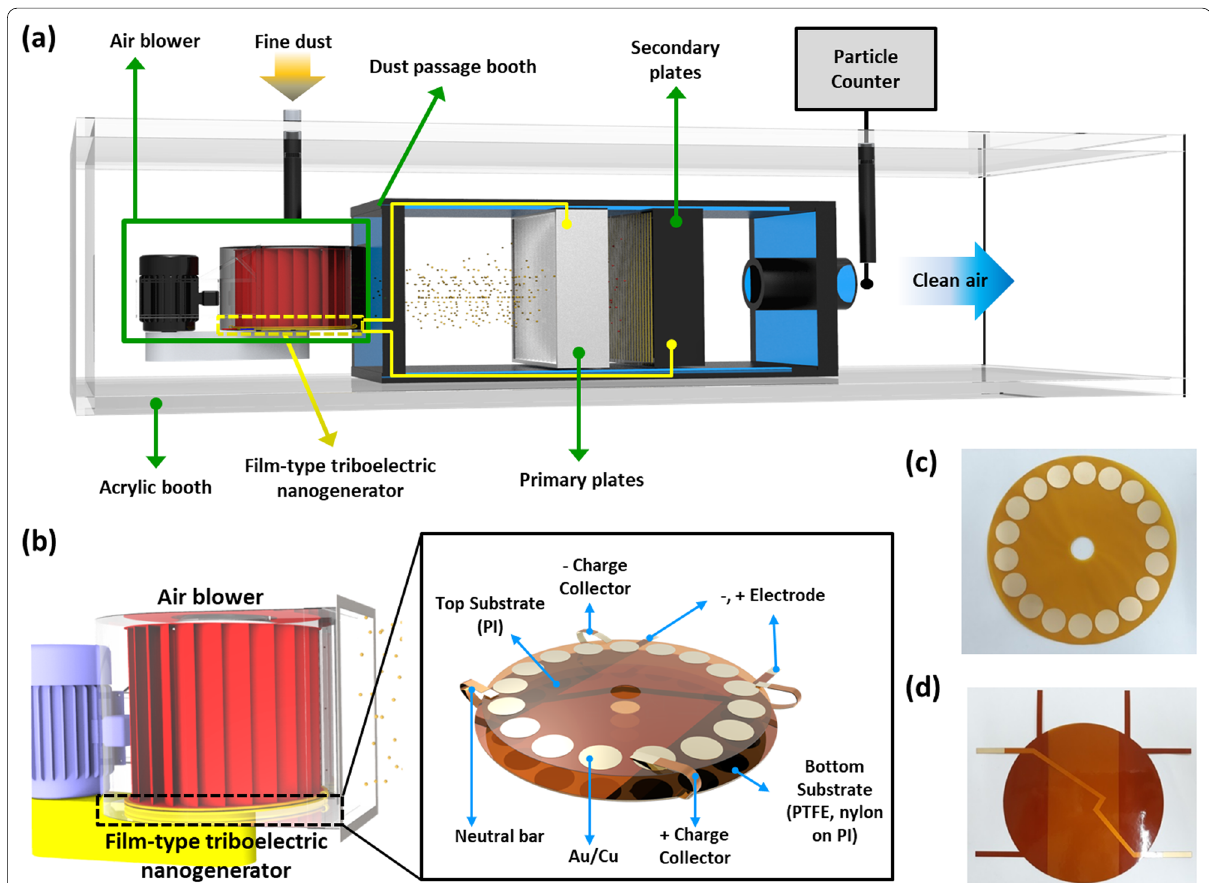
Fig. 1 a Schematic description of the TENG‑based fine dust filtration system. b Schematic design of the rotation‑type TENG. c and d As fabricated stator and the rotator of the